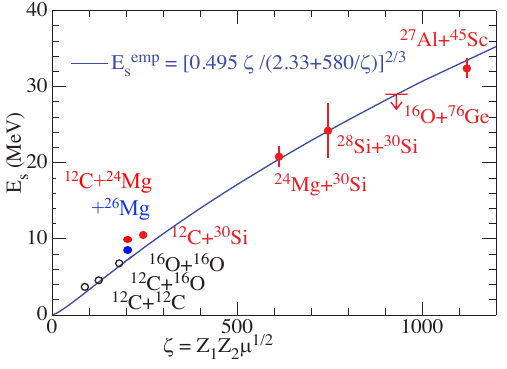
Figure 5. Threshold energies for hindrance in light and medium-light